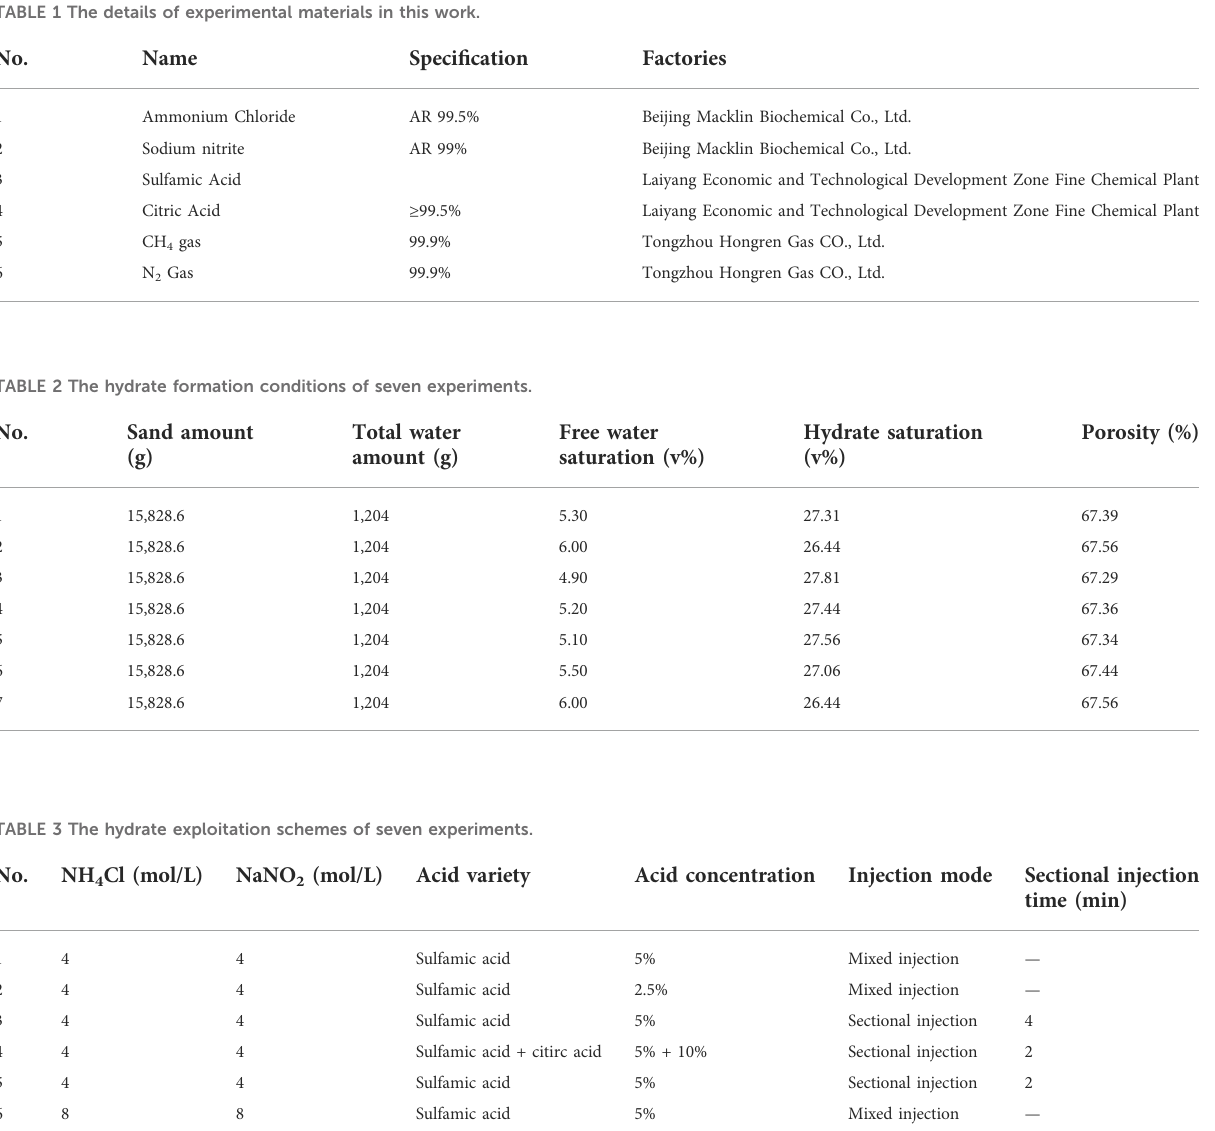
TABLE 1 The details of experimental materials in this work.